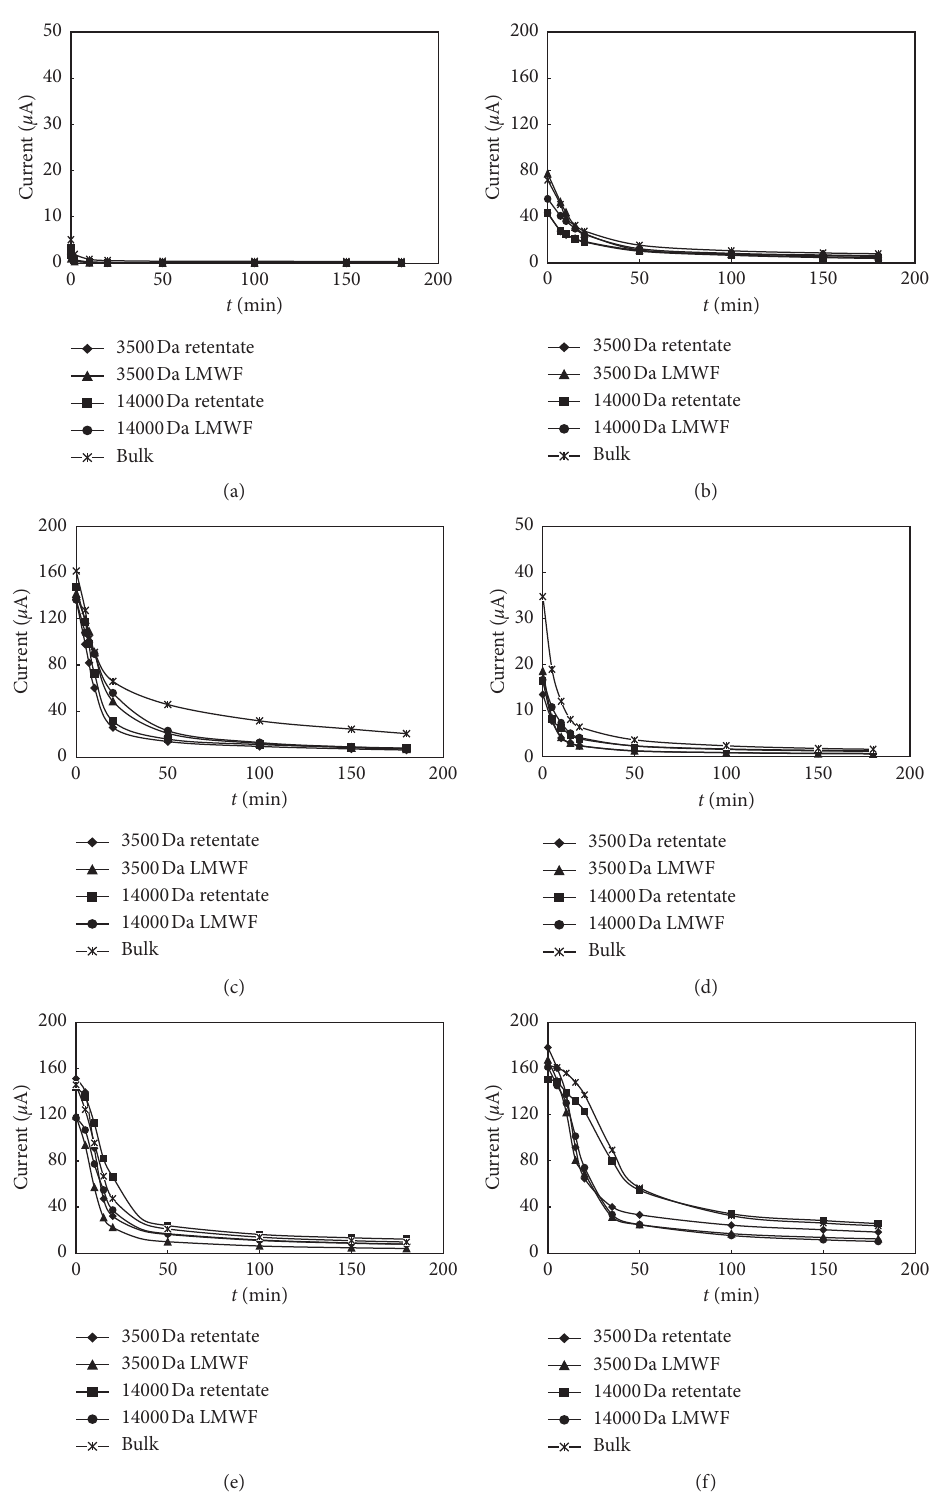
Figure 1: The I-t curve of different molecular weight fractions of PPNOM and LNOM in DER, which was carried out at E E h � − 0.59V, and E h � − 0.69V for 3 hours: (a) PPNOM − 0.49V; (b) PPNOM − 0.59V; (c) PPNOM 0.69V; (d) LNOM − 0.49V; (e) LNOM − 0.59V; (f) LNOM −